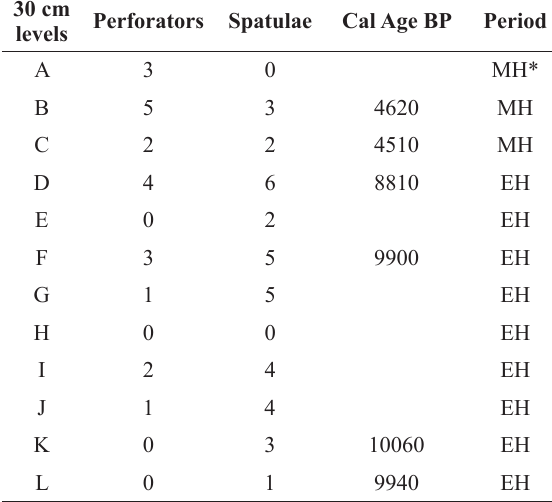
*This level contains some very late ages (880 BP), but they are probably related to the episodic use of the rockshelter by ceramist groups. We do not consider the stone and bone artifacts related to these late occupants.